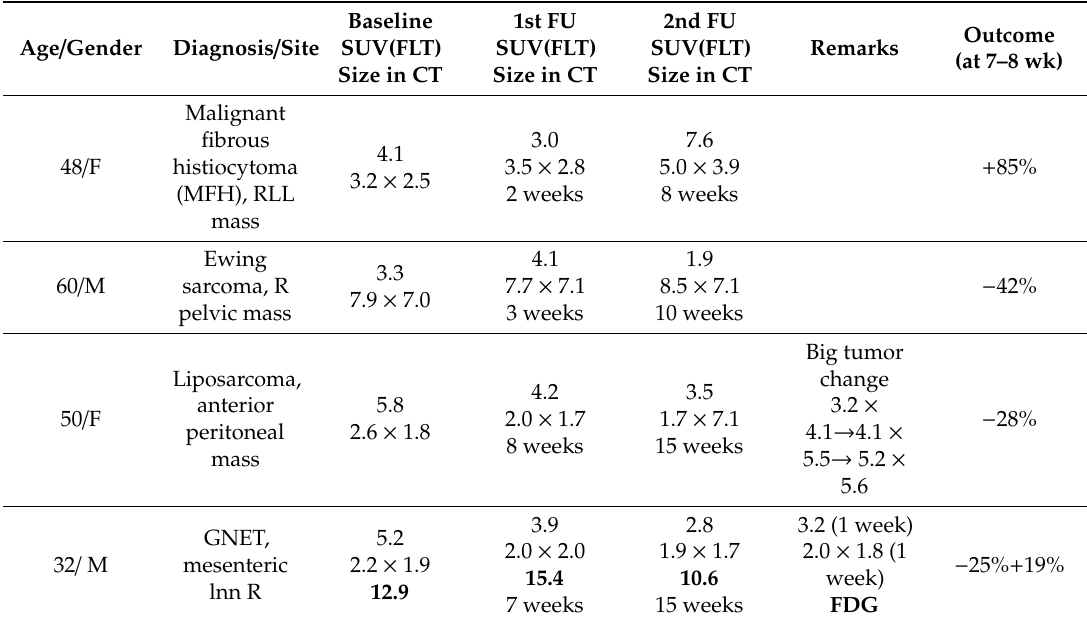
Table 1. The 3 (cid:48) -deoxy-3 (cid:48) [(18)F]-fluorothymidine (FLT)-positron emission tomography (PET) kinetics in a minimum of three time points at 1–15 weeks in patients with sarcoma treated with mdm-2 inhibitors. Age /